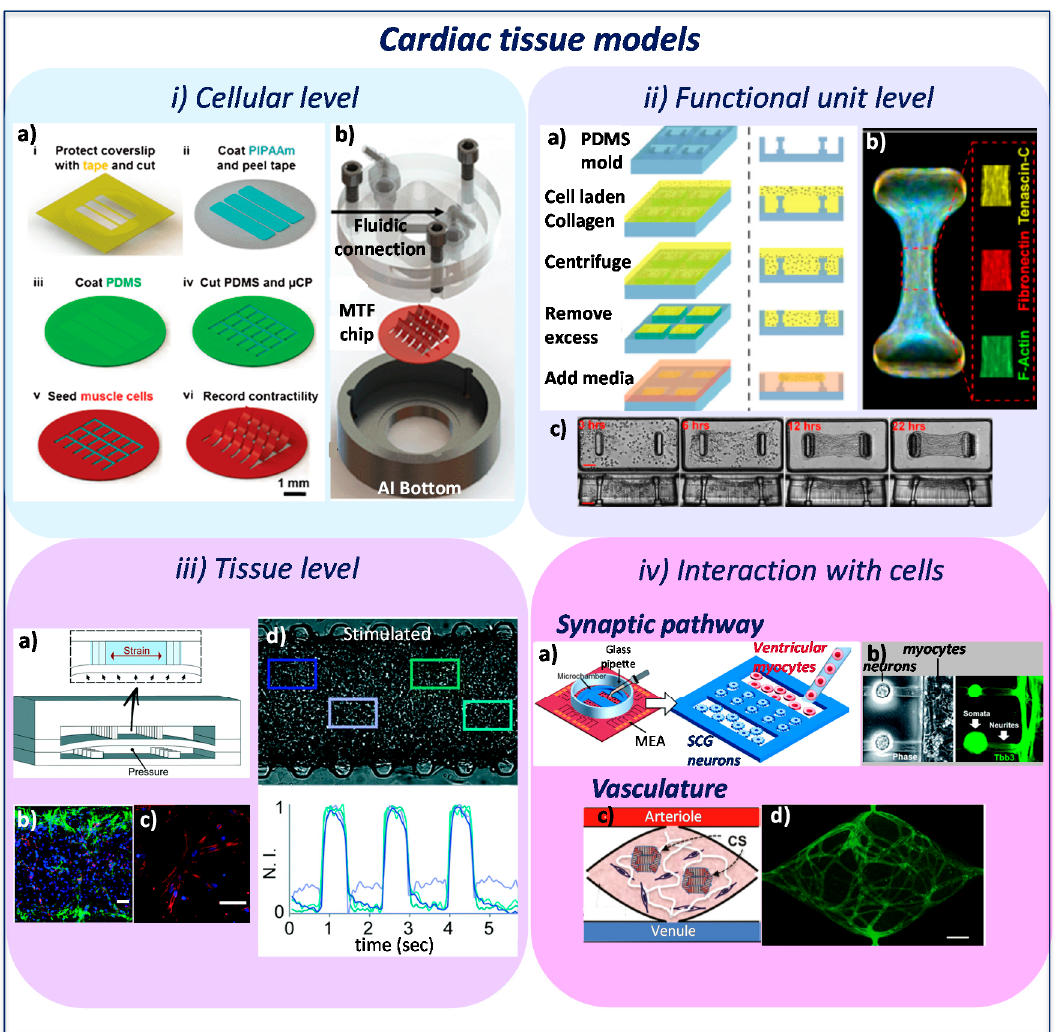
Figure 4. Platforms designed to create in vitro cardiac tissue models to investigate different features of myocardial organization. At cellular level, the muscular thin film (MTF) [49] used to investigate the cardiac functional contractility related to the sarcomere organization: ( i-a ) schematic step-by-step representation of MTF fabrication processes and ( i-b ) the fluidic device assembly. At the functional unit level, the microfabricated tissue gauges ( μ TUGs) [51] exploited to study the functional contractility related to cell alignment and reorganization: ( ii-a ) process flow of μ TUGs creation; ( ii-b ) immunofluorescence of ECM and cytoskeletal proteins in microtissues and ( ii-c ) time course of a contracting cardiac microtissue. At tissue level, the microengineered cardiac tissue ( μ ECTs) [18] showing physiological beating in response to physiological mechanical stimulation: ( iii-a ) design of the 3D heart-on-chip microdevice used to impose a strain to the tissue by pressurizing the bottom compartment; ( iii-b ) immunofluorescence of cardiac troponin I (green) and connexin 43 (red) and ( iii-c ) sarcomeric- α -actinin (red) after five days in culture (scale bar 100 μ m); ( iii-d ) evaluation of the contraction period in four different areas of the constructs showing the beating synchronicity reached by tissues. To study the interaction with other cells, platforms to reproduce the synaptic pathway [52] ( iv-a , iv-b ) and the cardiac vasculature [53] ( iv-c , iv-d ): ( iv-a ) seeding procedure of PDMS microchambers on a micro electrode array (MEA) surface to separately co-culture neurons and myocytes; ( iv-b ) fluorescence immunostaining showing the neurite extending in the myocyte compartment; ( iv-c ) scheme of designed platform to create vasculature around cardiac muscle spheroid (CS) and ( iv-d ) fluorescence microscopy of CD31-stained (green) vessels within the microtissues (scale bar 200 μ m).